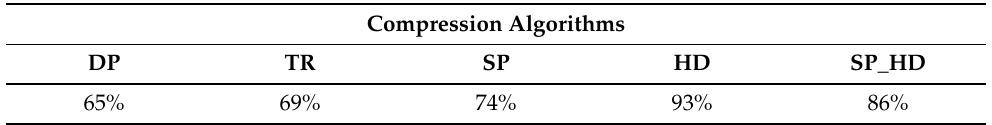
Table 7. Percentage of correctly classified mobility patterns for each compression algorithm. DP, Douglas–Peucker; TR, Time Ratio; SP, Speed based; HD, Heading based. Compression